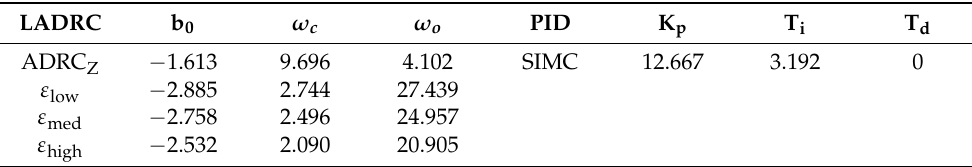
Table 9. Parameters for the control of a thermoelectric module.